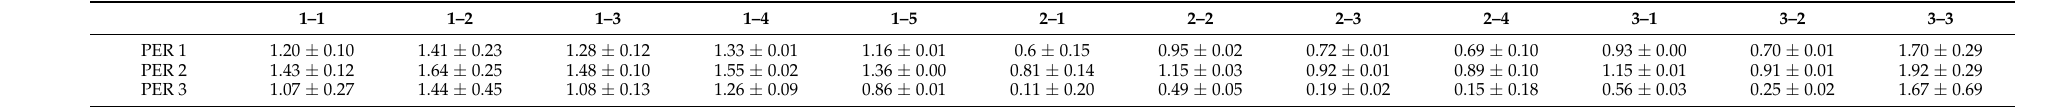
Table 8. Predict PER of fresh corn from three regions.